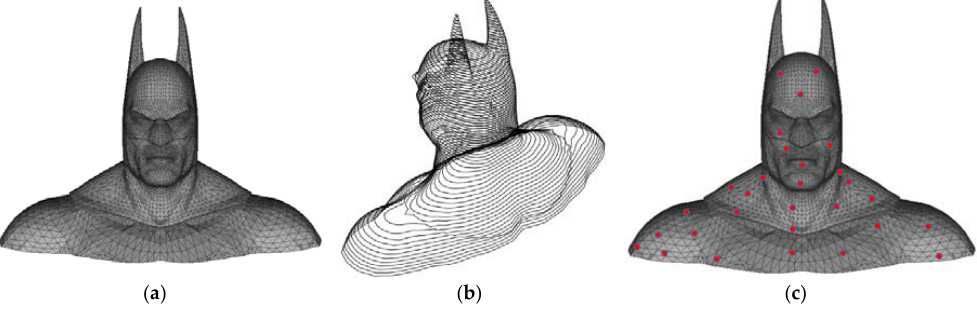
Figure 3. ( a ) 3D triangle mesh with vertices; ( b ) the 3D triangle mesh is cut into slices; and ( c ) feature points of the 3D triangle mesh.